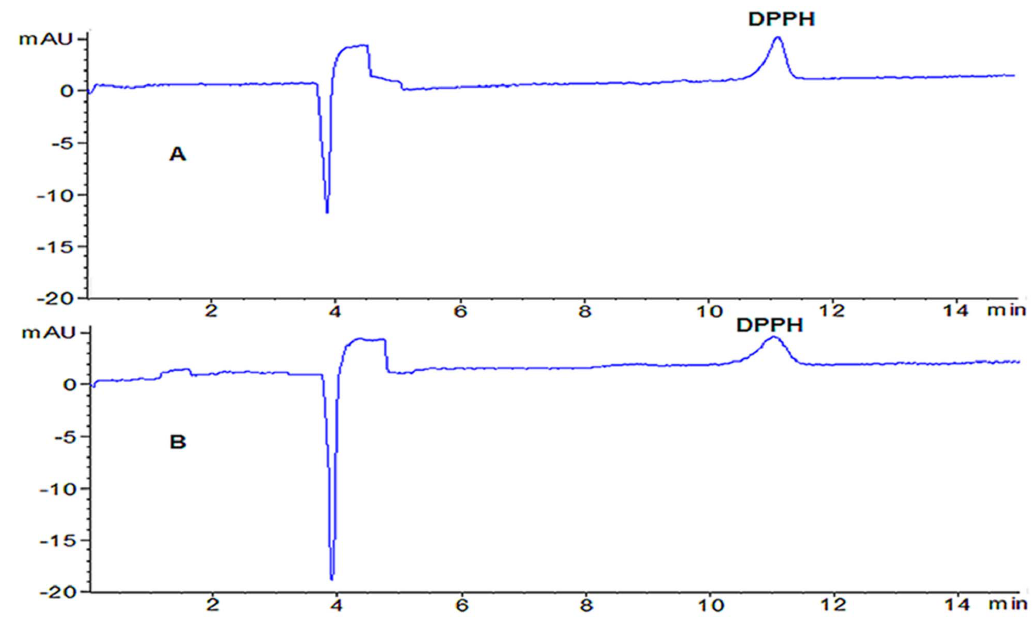
Figure 1. Capillary electropherograms of DPPH: (A) DPPH solution and (B) on-line mixed with Reduning injection (n=3). Experimental conditions: 50 m m i.d. 6 375 m m o.d. 6 60.5 cm length (52 cm effective length), uncoated; 20 mM NaH 2 PO 4 (pH 6.0)–50 mM SDS, voltage, 25 kV; temperature, 22 u C; detection wavelength, 517 nm; pressure injection, 50 mbar for 5 s.